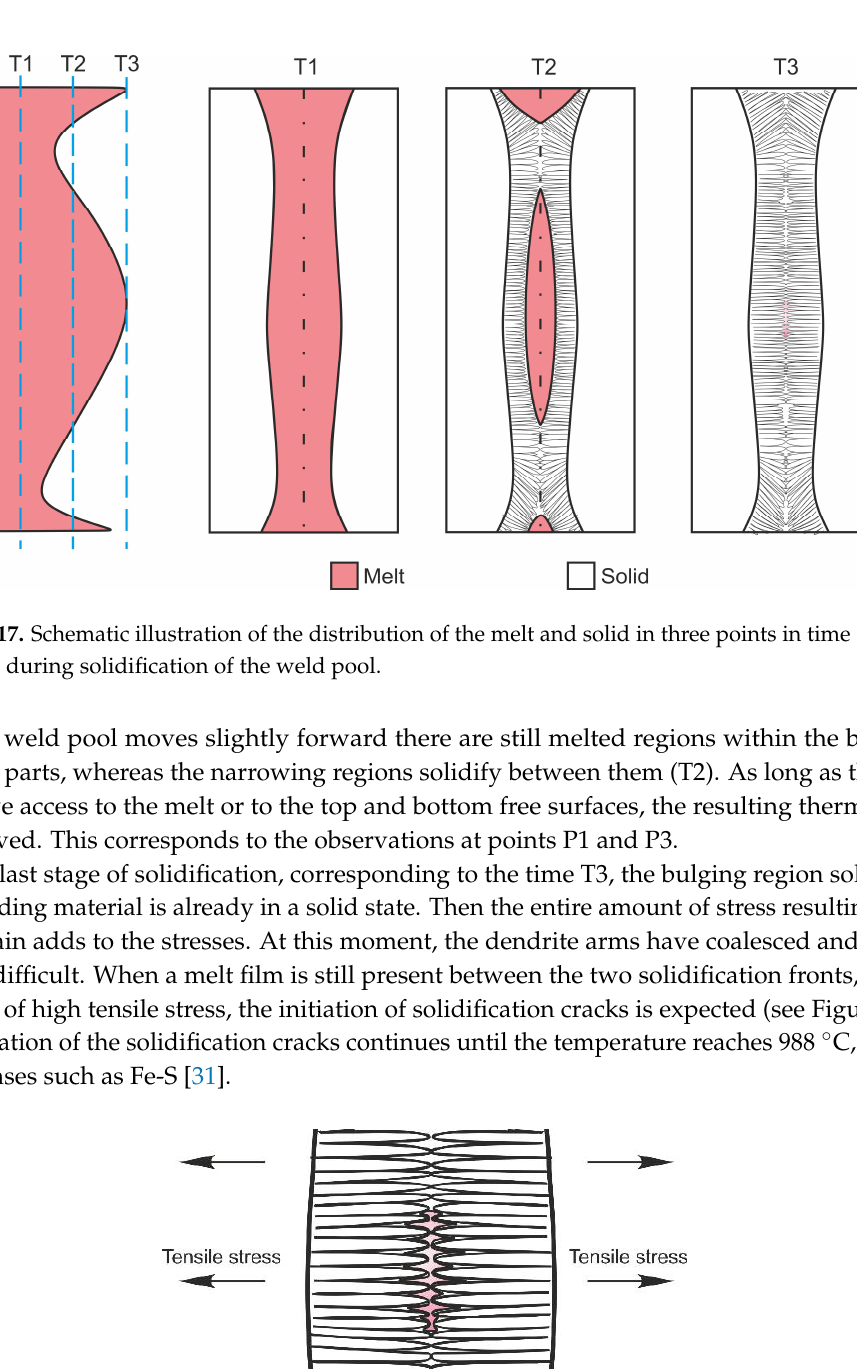
Figure 18. Schematic representation of solidification cracking in the bulging region.